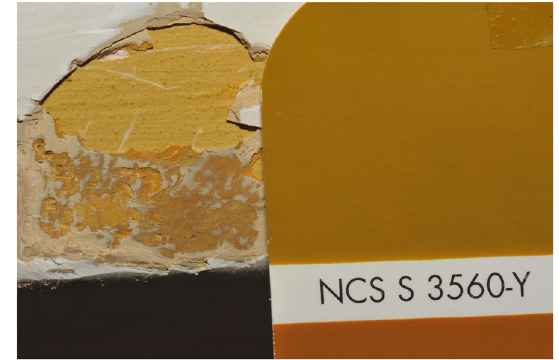
Fig. 8 Magnified detail of the yellow paint layer (opening approximately 30 mm wide). The darker tone in the lower part of the opening is the original finish. (Source: photograph reproduced with the permission of Zhong Tang)